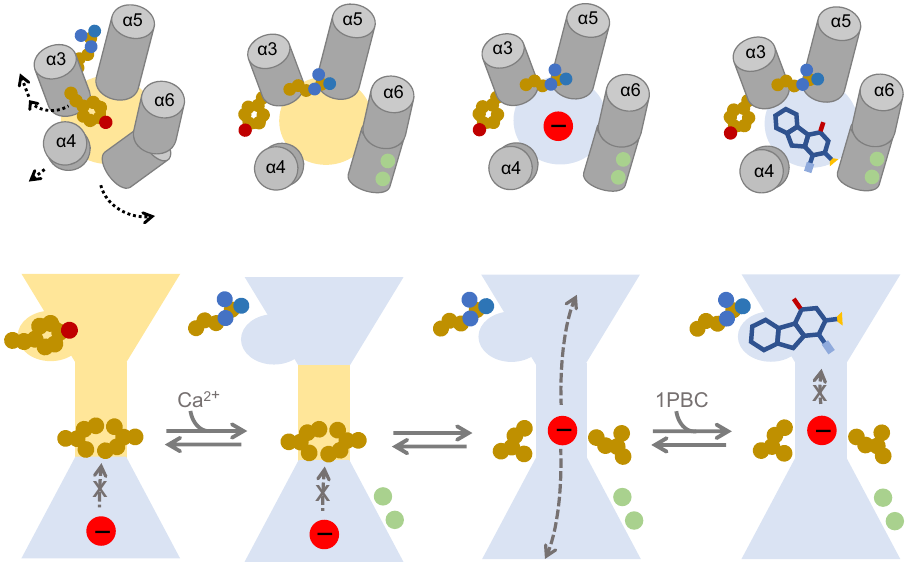
Fig. 9 Mechanism. In the Ca 2 + -free closed state, constrictions in the narrow neck and extracellular vestibule limit the access of either anions or the blocker 1PBC, whose binding site is occupied by Tyr 514 on α 3. Ca 2 + binding results in a series of transitions in the channel that opens the pore by rearranging the outer vestibule. The outward movement of α 4 widens the outer pore entrance, while the more extended conformational change of α 3 relocates Tyr 514 away from the pore and projects the adjacent Arg 515 towards the pore lumen, creating a site that accommodates the blocker. These rearrangements are subsequently propagated to the intracellular part of the narrow neck region to release a hydrophobic gate that stabilizes the constricted pore in the closed state. The binding of the blocker to the site immediately external to the narrow neck results in a direct blockade of the ion conduction path, thereby inhibiting channel activity. Blocker access to a pre-open conformation, where the site is already remodeled but the gate is still closed, appears to be feasible and might be represented in the observed